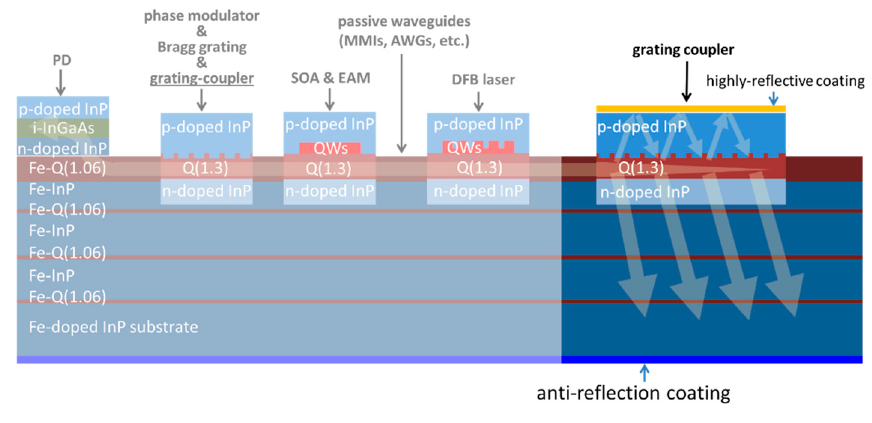
Figure 9. Schematic showing an implementation of grating couplers on the generic-foundry-service process.